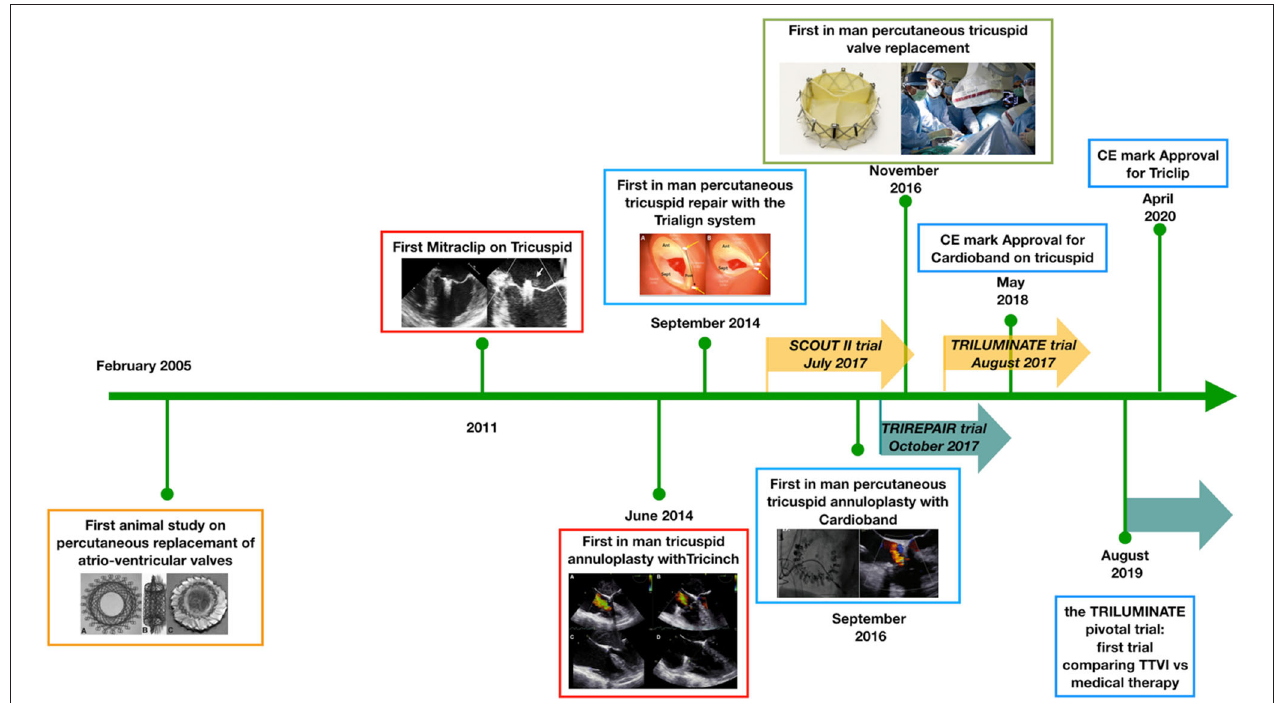
FIGURE 1 | Developmental timeline of percutaneous tricuspid valve interventions. Since 2005, a number of technologies have been developed to address the problem of tricuspid regurgitation. At present, the first randomized controlled trials are enrolling patients to establish the potential effectiveness of percutaneous treatments over medical therapy. TTVI, transcatheter tricuspid valve intervention; CE, Conformité